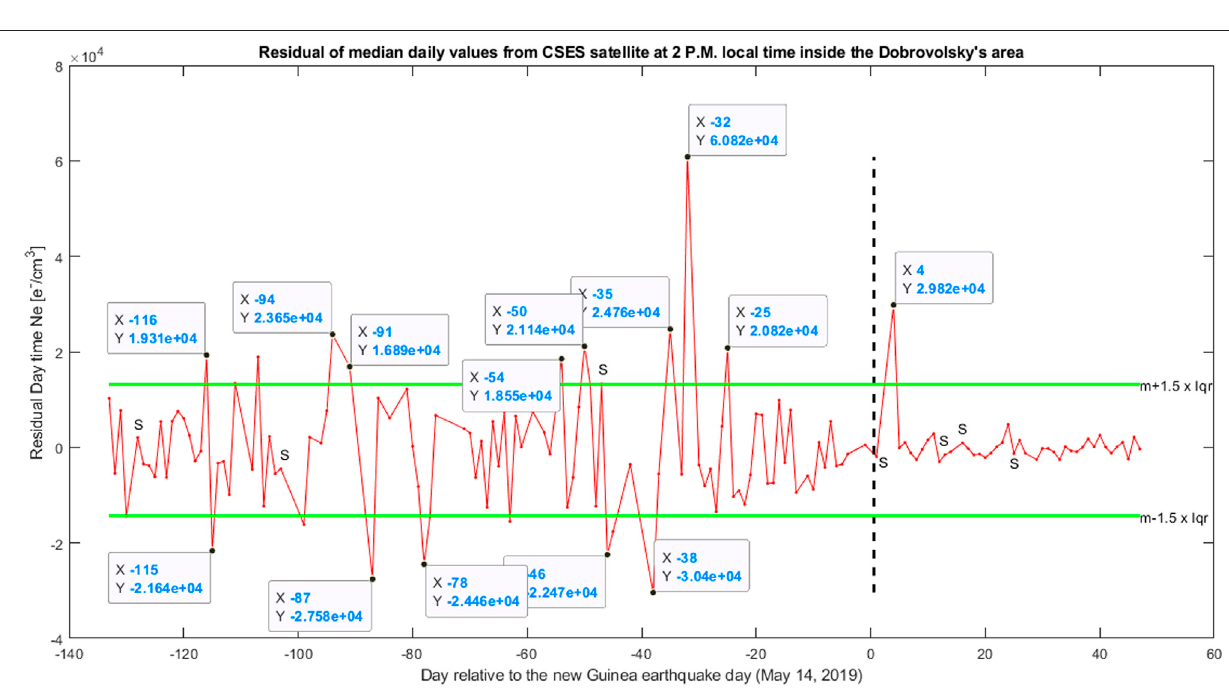
Frontiers in Earth Science |